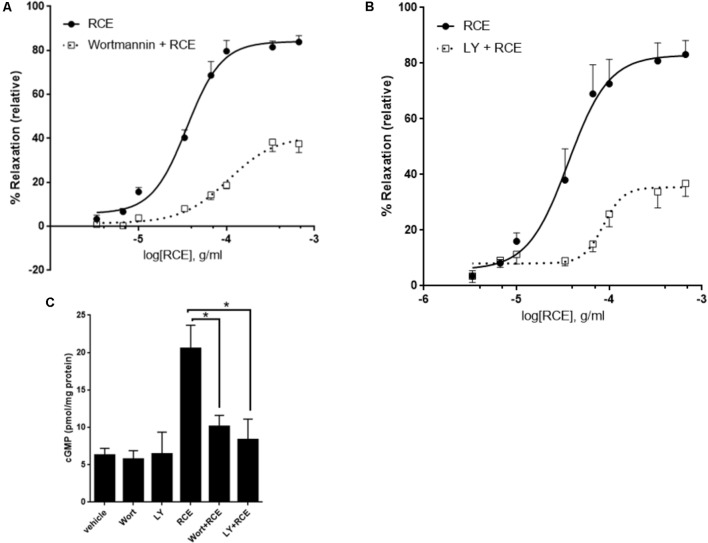
PI3-K/Akt axis is actively involved in RCE-driven relaxation of rat aorta. Endothelium-intact rings were exposed to cumulative doses of sumac in the absence (circles) or prior presence of (A) Wortmannin (0.1 μM; squares) or (B) LY294002 (10 μM; squares). Data represents mean ± SEM (n = 7; p < 0.01 for RCE versus either Wortmannin + RCE or LY294002 + RCE). (C) Rings were incubated without or with RCE after having been pre-treated without (vehicle) or with wortmannin (0.1 μM) or LY294002 (10 μM) for 30 min. cGMP levels were then assayed. n = 7; ∗p < 0.01.